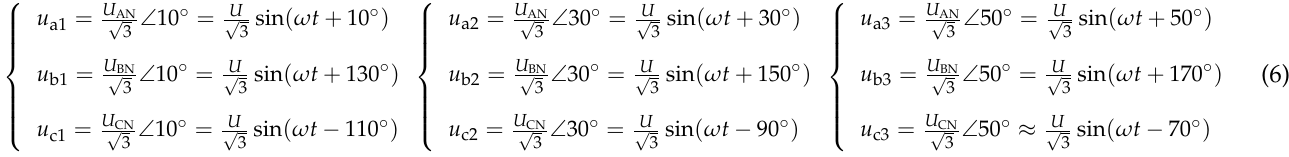
From Equation (6), the output voltages of the rectifier bridges are described as Figure 4. In Figure 4, the voltages u KF , u FS , and u SG have 6 pulses per supply cycle with a phase difference of 20 degrees, and each pulse lasts 60 degrees.